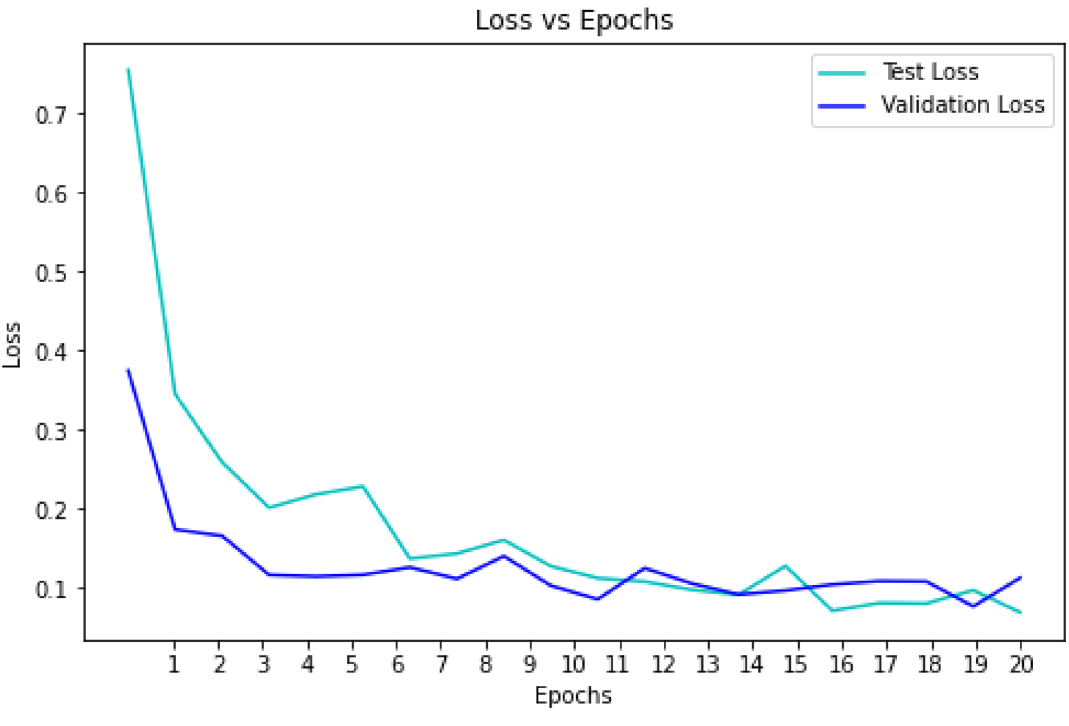
Figure 8. Model Loss graph.